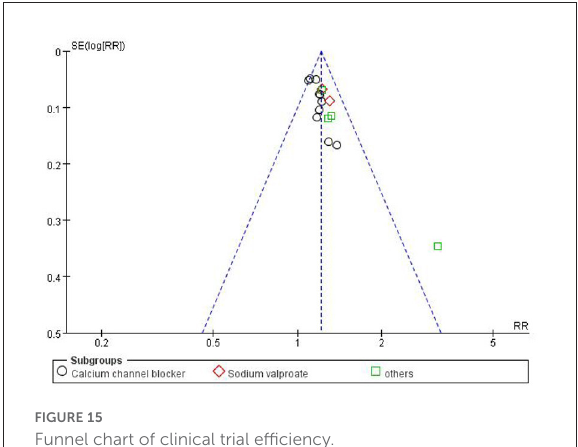
FIGURE15 Funnel chart of clinical trial